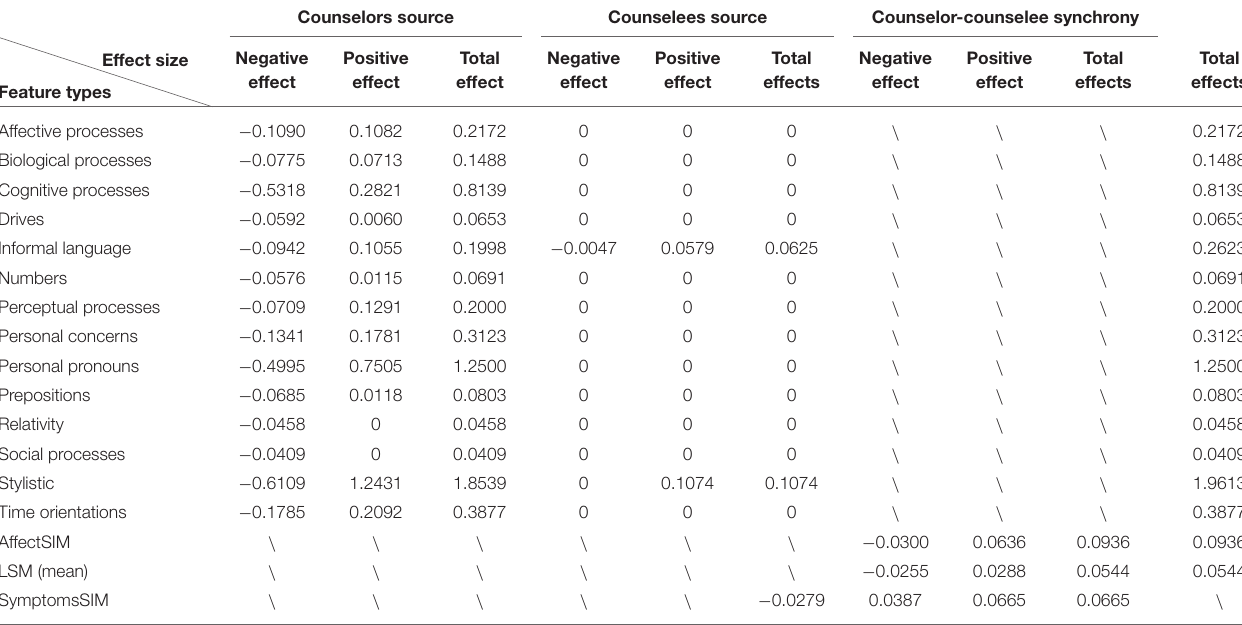
TABLE 2 | Cumulative SHAP values for different sources and types of linguistic cues in the perceived helpfulness predictive